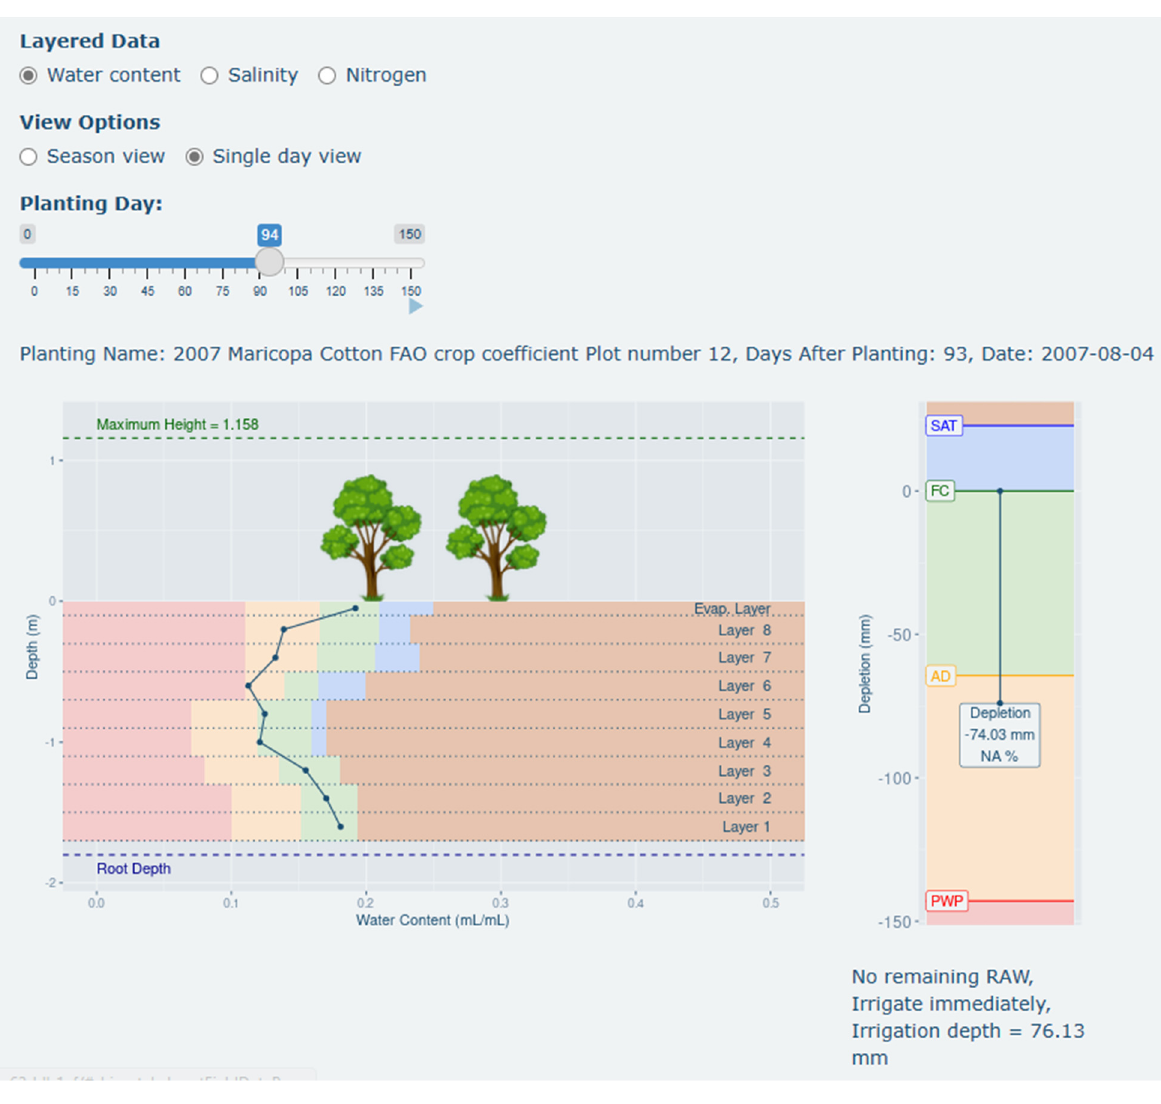
Figure 12. WINDS (Water-use, Irrigation, Nitrogen, Drainage, and Salinity) model irrigation scheduling and visualization page (h tt ps://vis.datascience.arizona.edu/WINDS/).